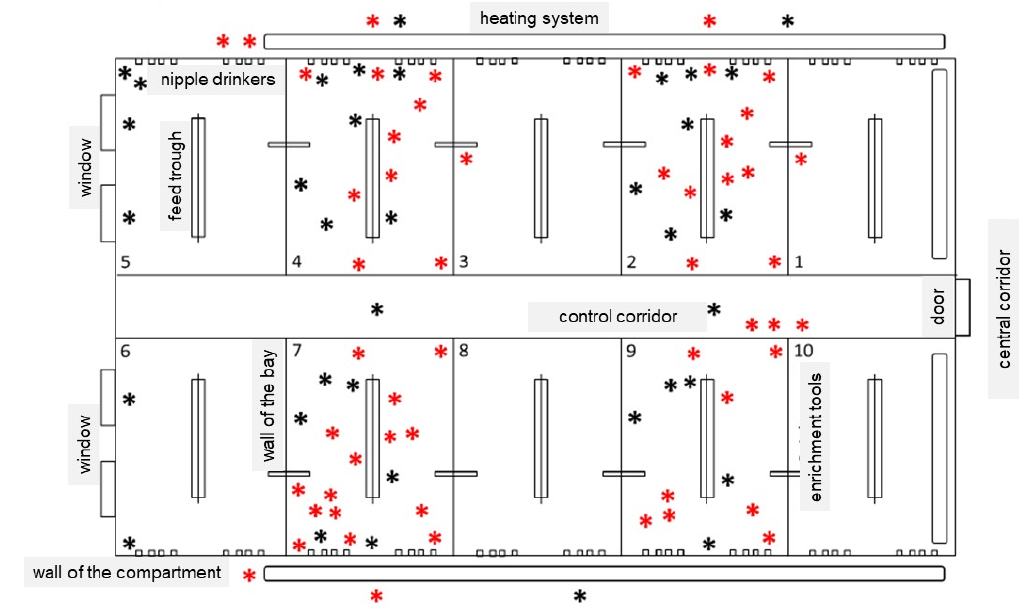
Figure 4. Schematic overview of the sampling locations in the lower part of the test compartment (<2 m height). * Black dots: easy to clean areas. * Red dots: difficult to clean areas.